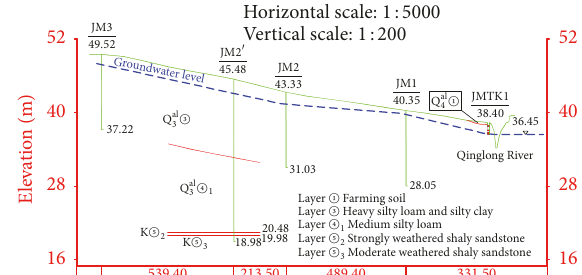
Figure 2: Geological profile of Jiangxiang reservoir showing loca- tion of test boreholes, groundwater levels, lithologic types, and distances between boreholes. The elevation was based on the Yellow Sea level. The numbers are the distances between two boreholes